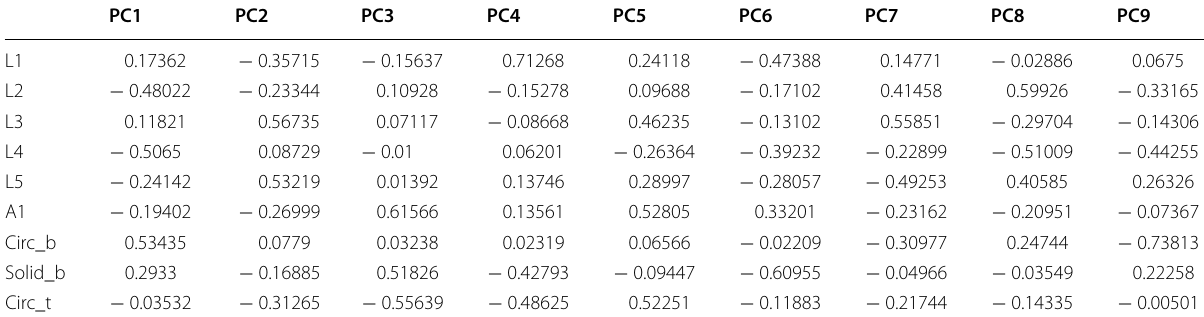
Table 2 Component loadings of PCA in Fig. 2